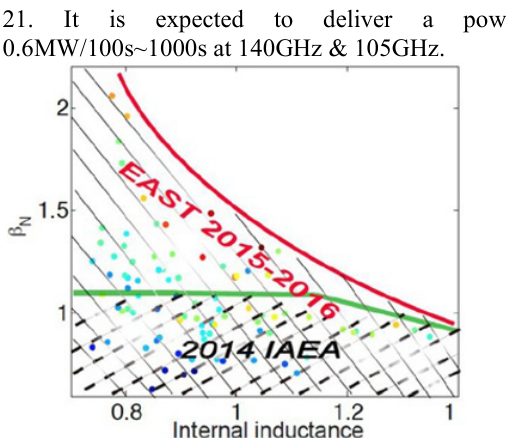
Fig. 18. Time evolution of key signals for low loop voltage start-up experiments.